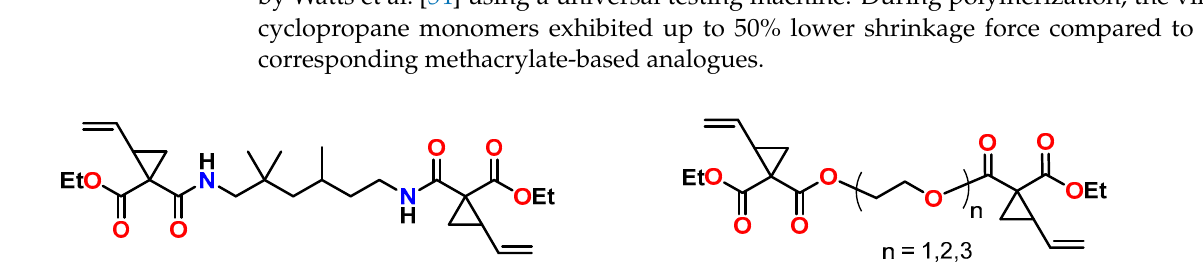
Figure 8. Chemical structure of selected vinylcyclopropanes for potential application in dental composites.